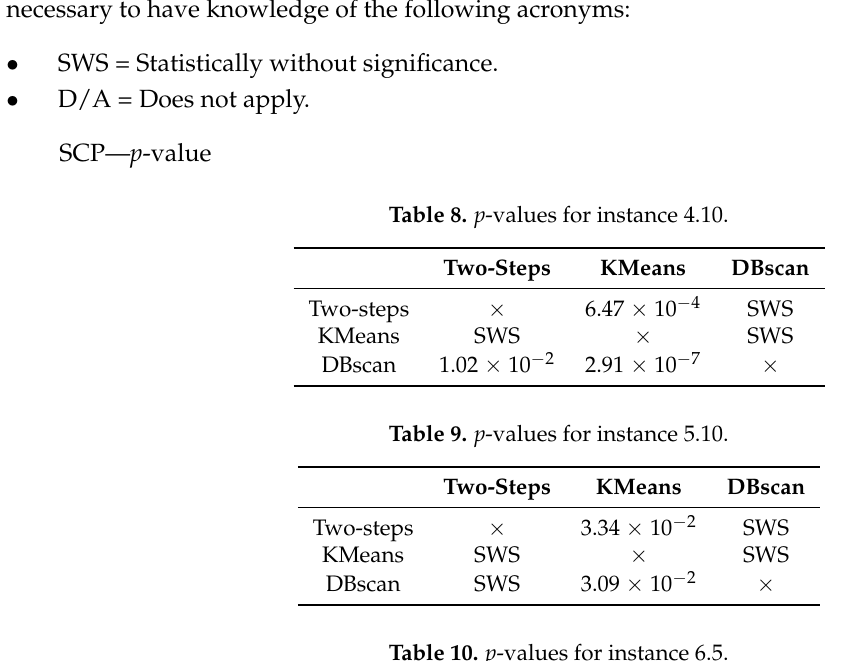
Table 10. p -values for instance